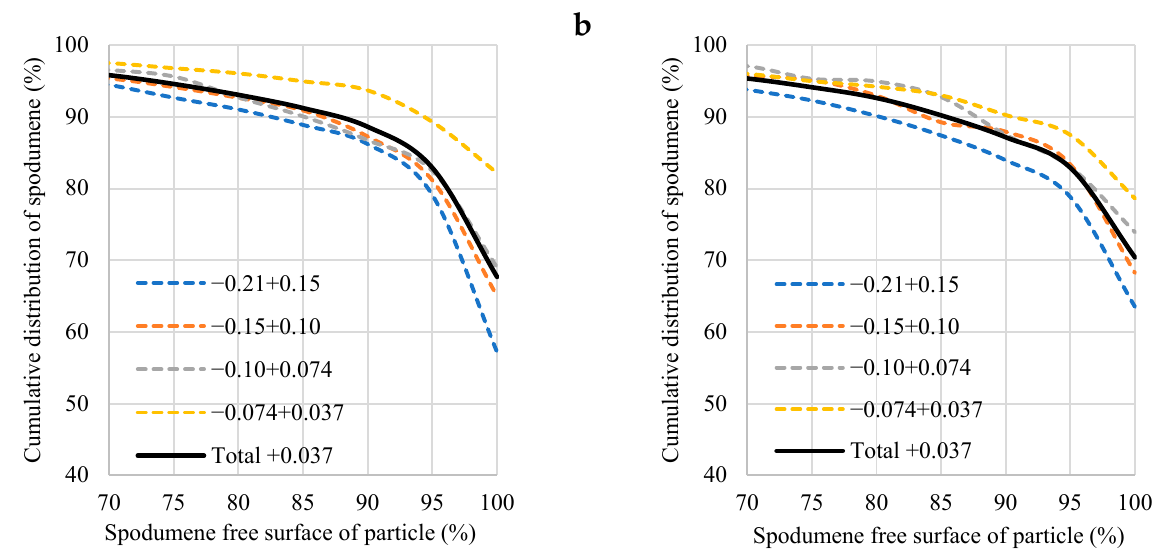
Figure 9. Mineral liberation by free surface area for spodumene in G1 ( a ) and G2 ( b ).